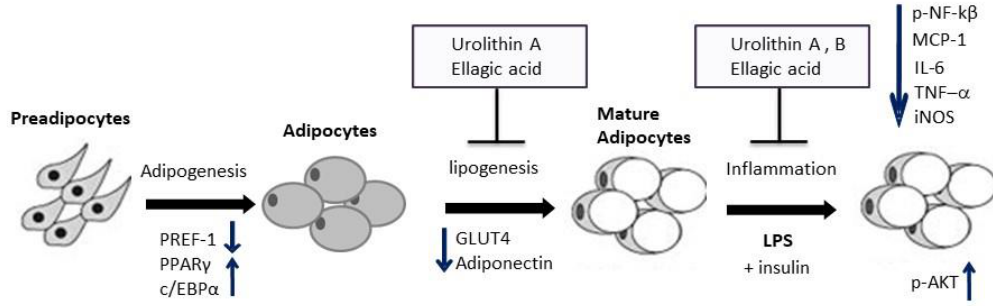
Figure 8. Proposed model of modulation of lipogenesis and inflammation by ellagic acid and derived gut microbial metabolites urolithins A and B in adipocytes. Ellagic acid (EA) and urolithins A and B did not affect adipogenesis in 3T3-L1 cells, where PREF-1 decreased and PPARγ and c/EBPα increased for all treatments. During lipogenesis/lipolysis, only EA and urolithin A reduced fat accumulation in mature adipocytes attenuating GLUT4 gene expression and adiponectin. In LPS-challenged cells, EA and urolithins A and B differentially ameliorated inflammation through down-regulation of transcription factor p-NF-κB and pro-inflammatory genes while not affecting insulin sensitivity, depicted by an increase in protein expression of transcription factor p-AKT when exposed to insulin.